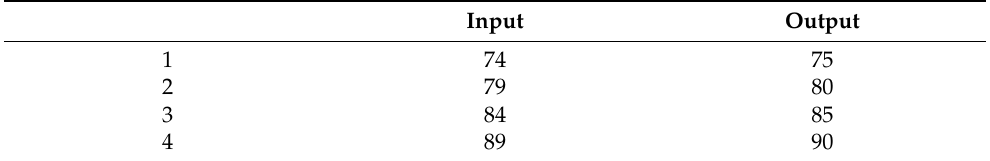
Table 7. Sliding window output and input